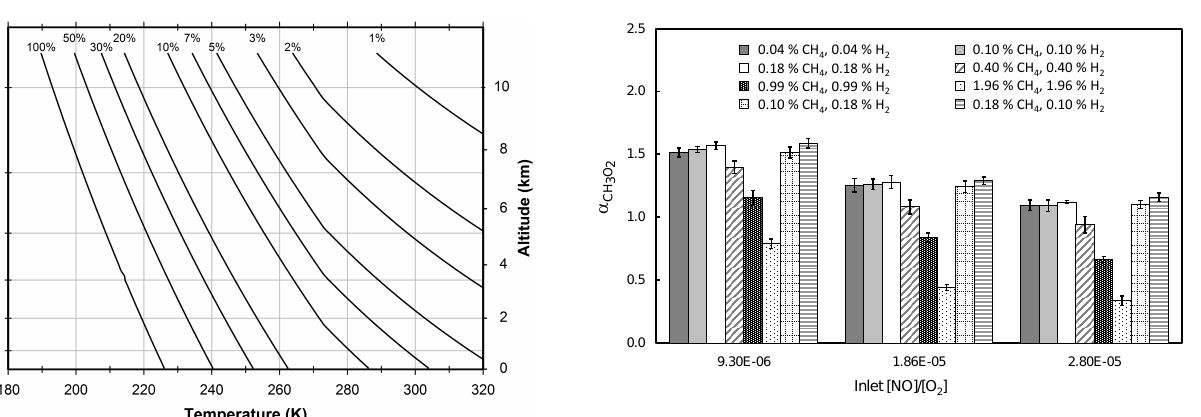
Fig. 5. The basic operating region for the PeRCIMS inlet: the curves show the calculated dependence on ambient pressure/altitude and temperature for a series of minimum ambient relative humidi- ties. Below the curves, modifications to increase water vapor in the inlet region are required to maintain measurement sensitivity.